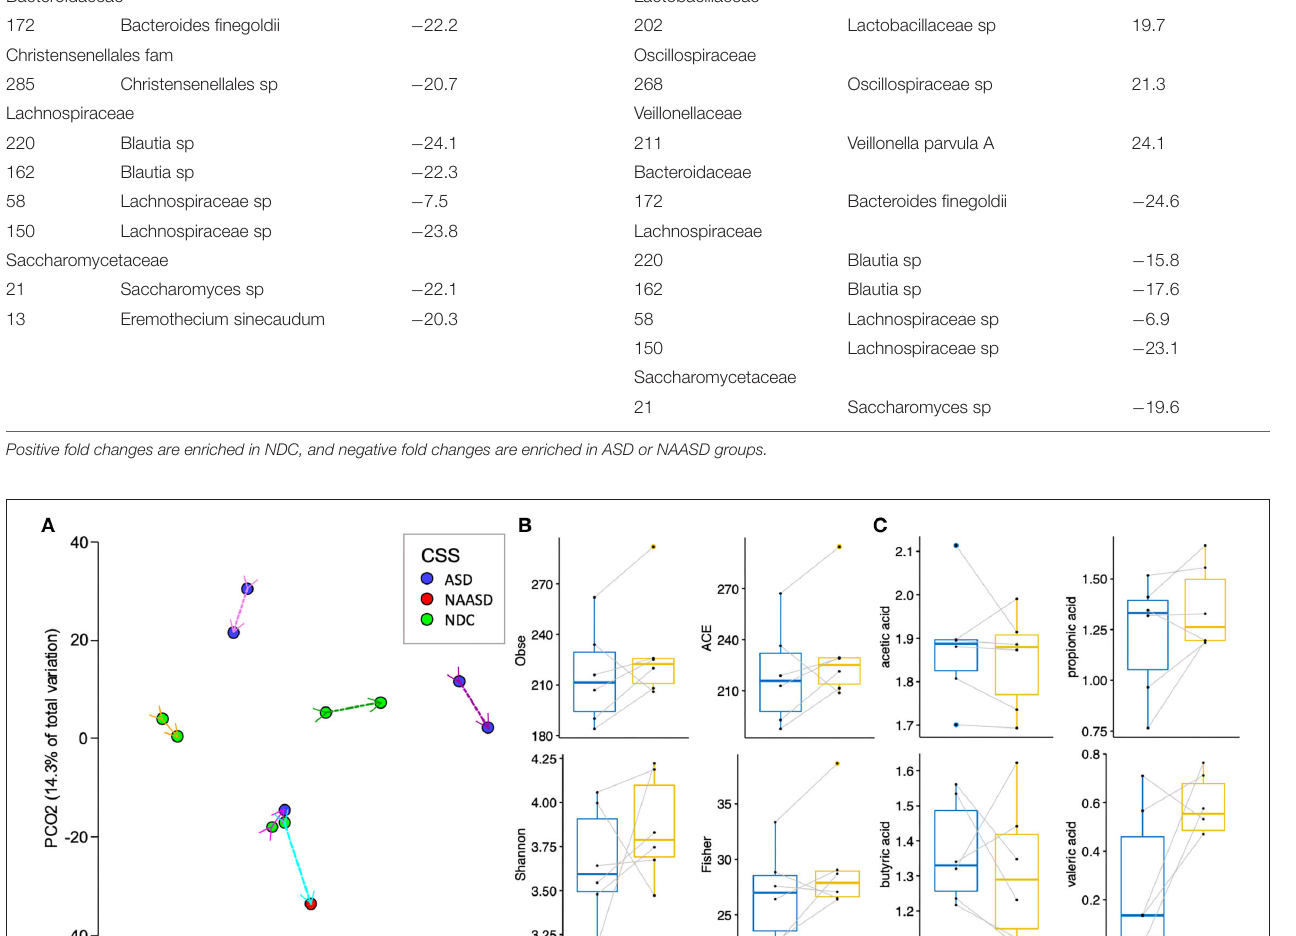
FIGURE 3 | Changes in the gut microbiome of 6 children between an average of 24 months of age (timepoint A), and 36 months of age (timepoint B). (A) PCoA of bacterial beta-diversity based on Euclidian distances of CLR transformed counts and the trajectory of the microbiome across time is shown with a uniquely colored arrow for each individual. (B) Alpha diversity estimates between timepoint A and B. (C) SCFA concentrations between timepoint A and B.